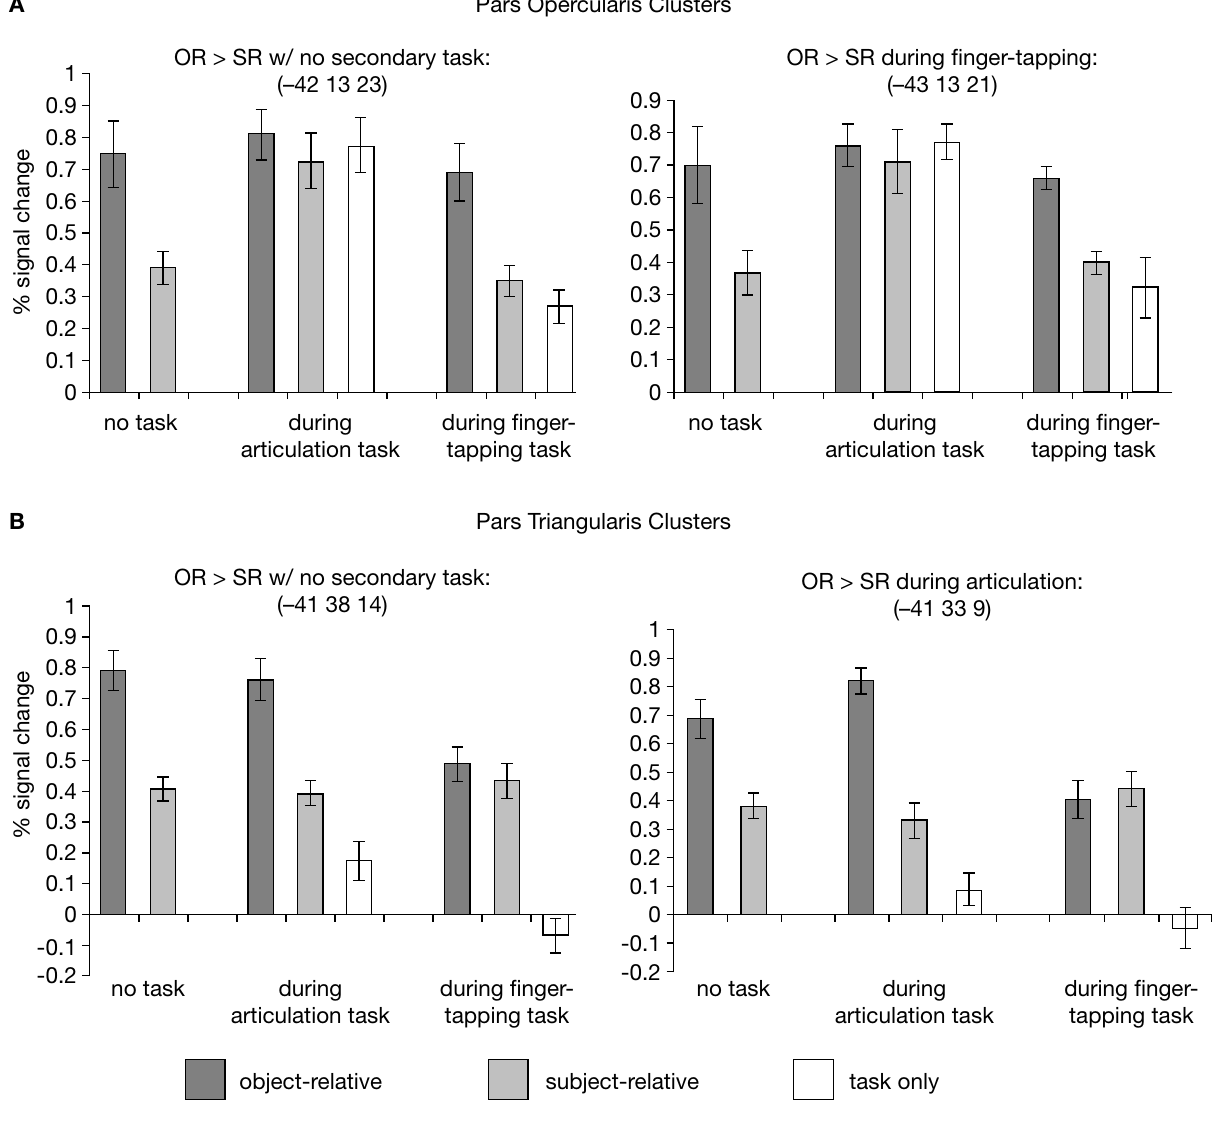
Figure 7 | Mean peak amplitudes of the left pars opercularis (A) and left pars triangularis (B) regions more active during the perception of object- relative sentences than during subject-relative sentences ( p < 0.005) in the absence of a secondary task, or during one of the concurrent tasks, averaged across trials and subjects. Mean peak amplitudes of each cluster are shown for each sentence type presented during each task condition, as well as for just articulation and fi nger-tapping alone. Error bars represent 95% confi dence intervals. The Talairach coordinates of each cluster’s peak are given, and correspond to the contrast maps in Figure